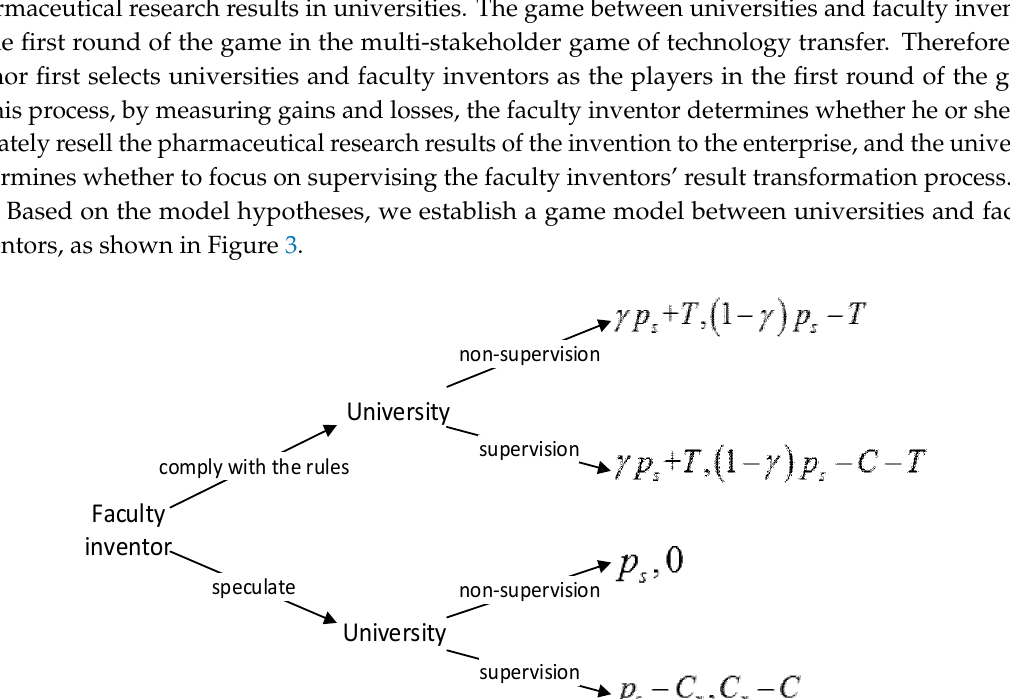
Table 2. Variables in the game model.